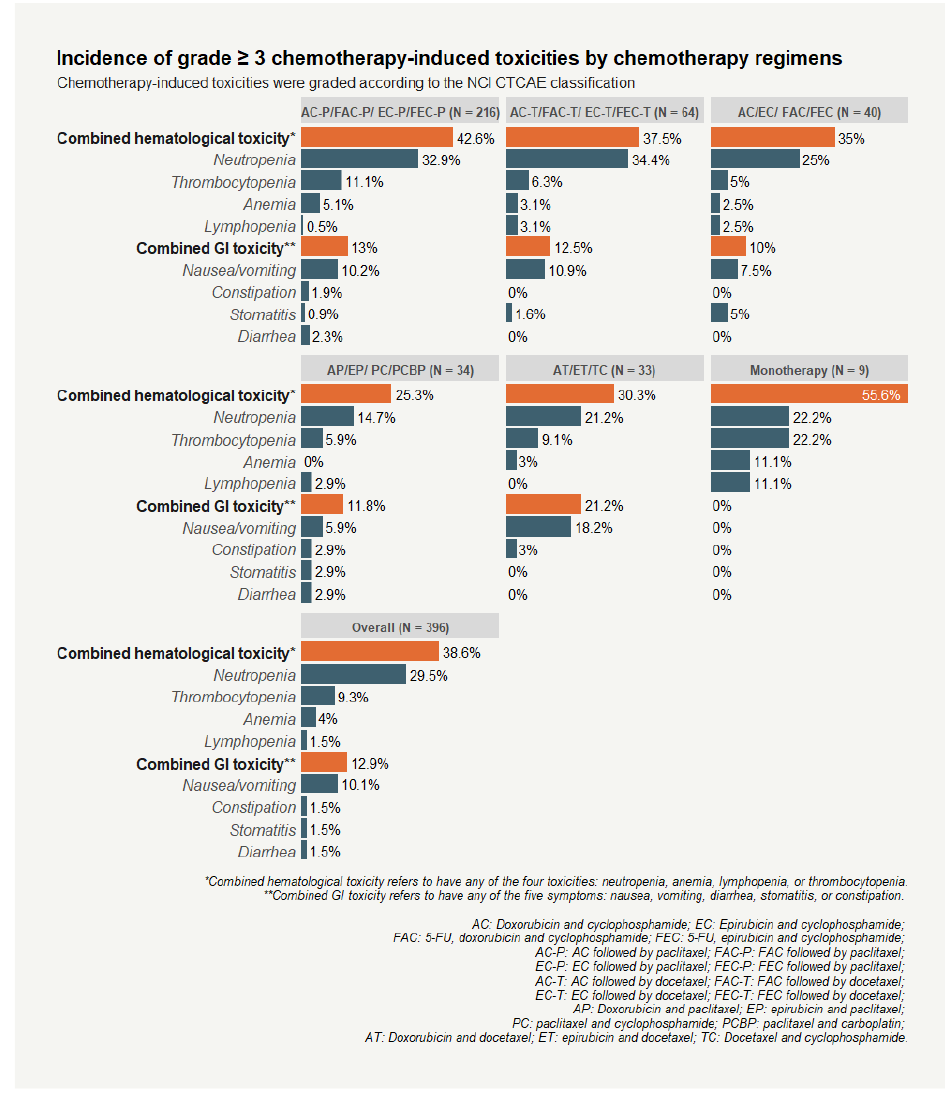
Figure 1. Incidence of grade ≥ 3 chemotherapy -induced toxicities among breast cancer patients by chemotherapy regimens.